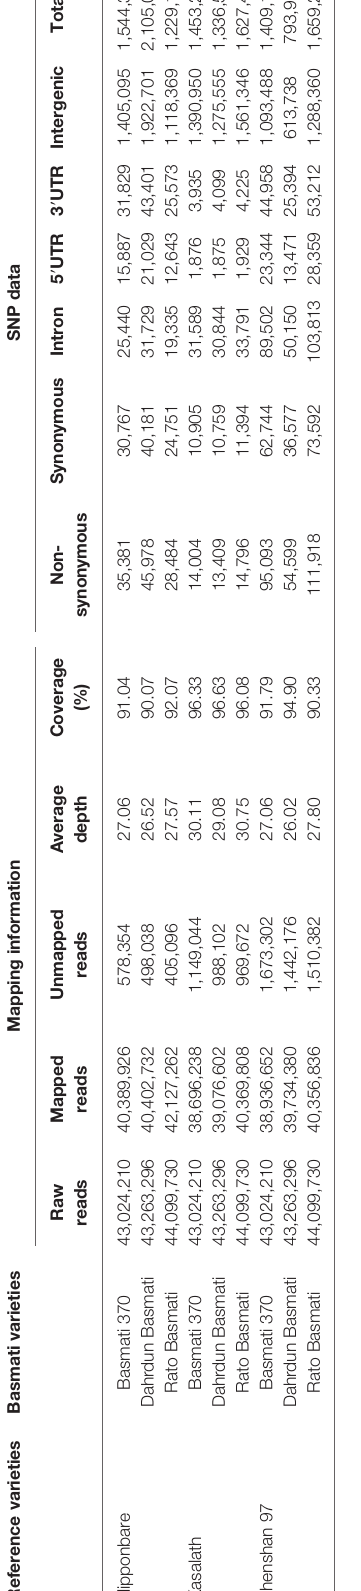
Supplementary Table 3 . PCR ampli fi cation of 289